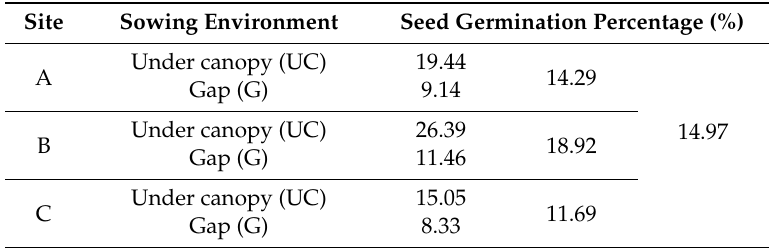
Table 4. Seed germination percentages from the late sowing period